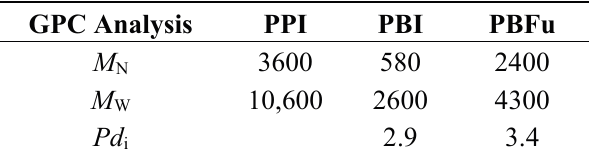
Table 1. GPC data for PPI, PBI and PBFu.